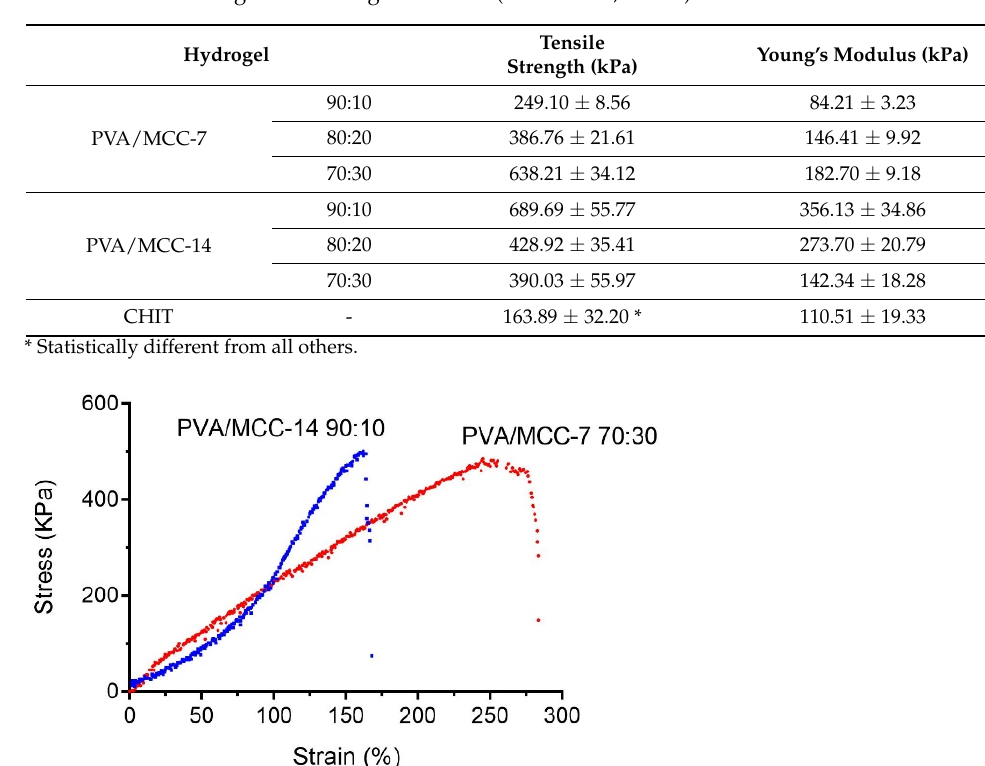
Table 6. Tensile strength and Young’s modulus (mean ± SE; n = 10).